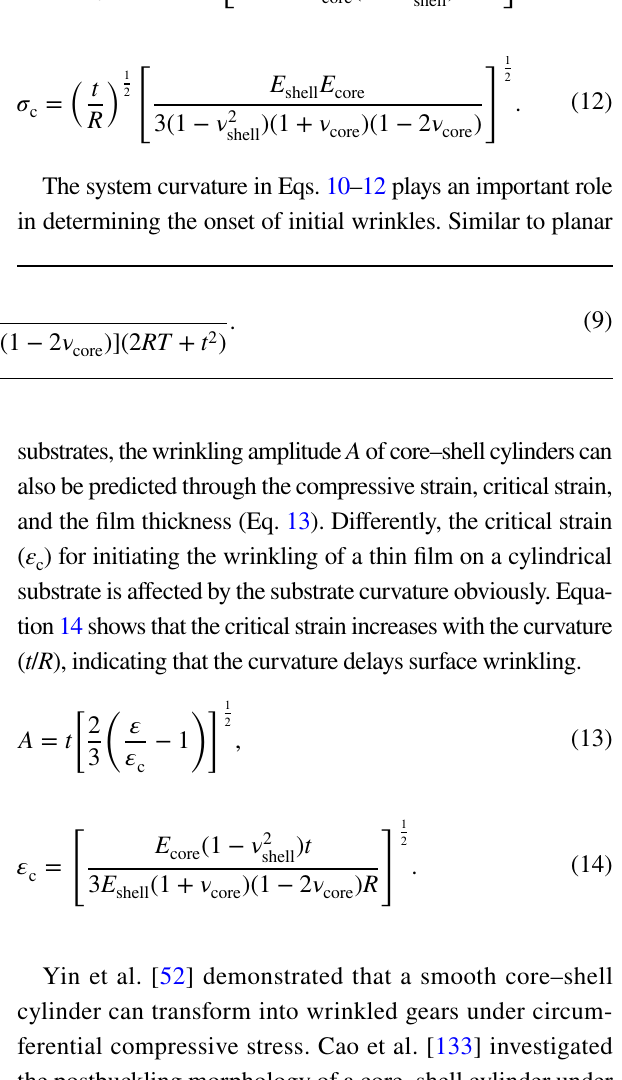
Fig. 3 Schematic of wrinkle formation in a typical core–shell system composed of a rigid shell bonded on a soft core under shrinking or expansion. R is the radius of the soft core, t represents the shell thick- ness, A and λ represent the amplitude and wavelength of the